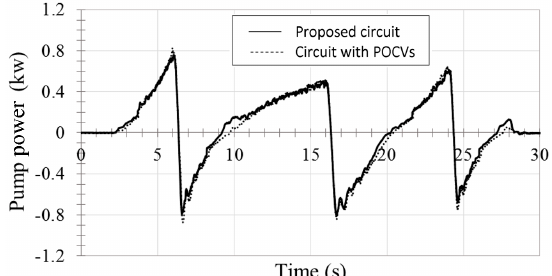
Figure 15. Hydraulic power delivered/received by the main pump in the circuit utilizing only POCVs and the proposed circuit for experiment in Figure 10 at four quadrants of operation and 368 kg mass.